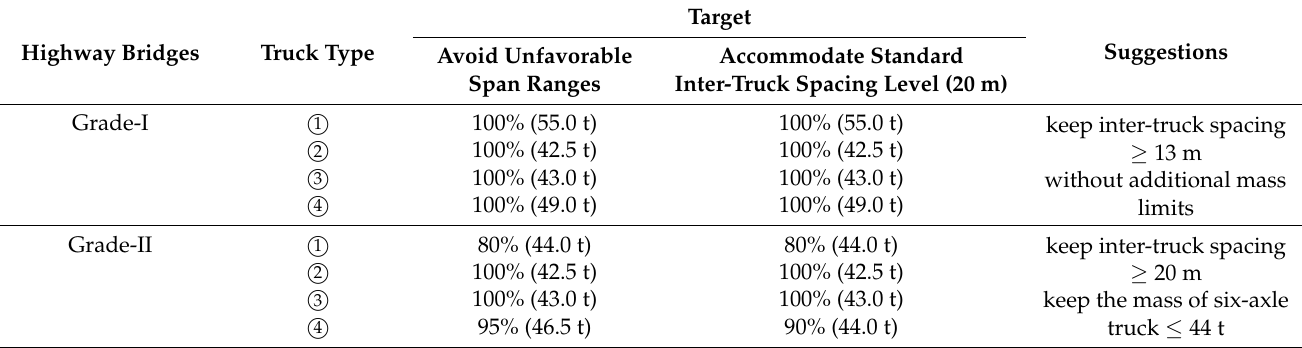
Table 2. Identified mass limits for platooning trucks crossing simply supported bridges.